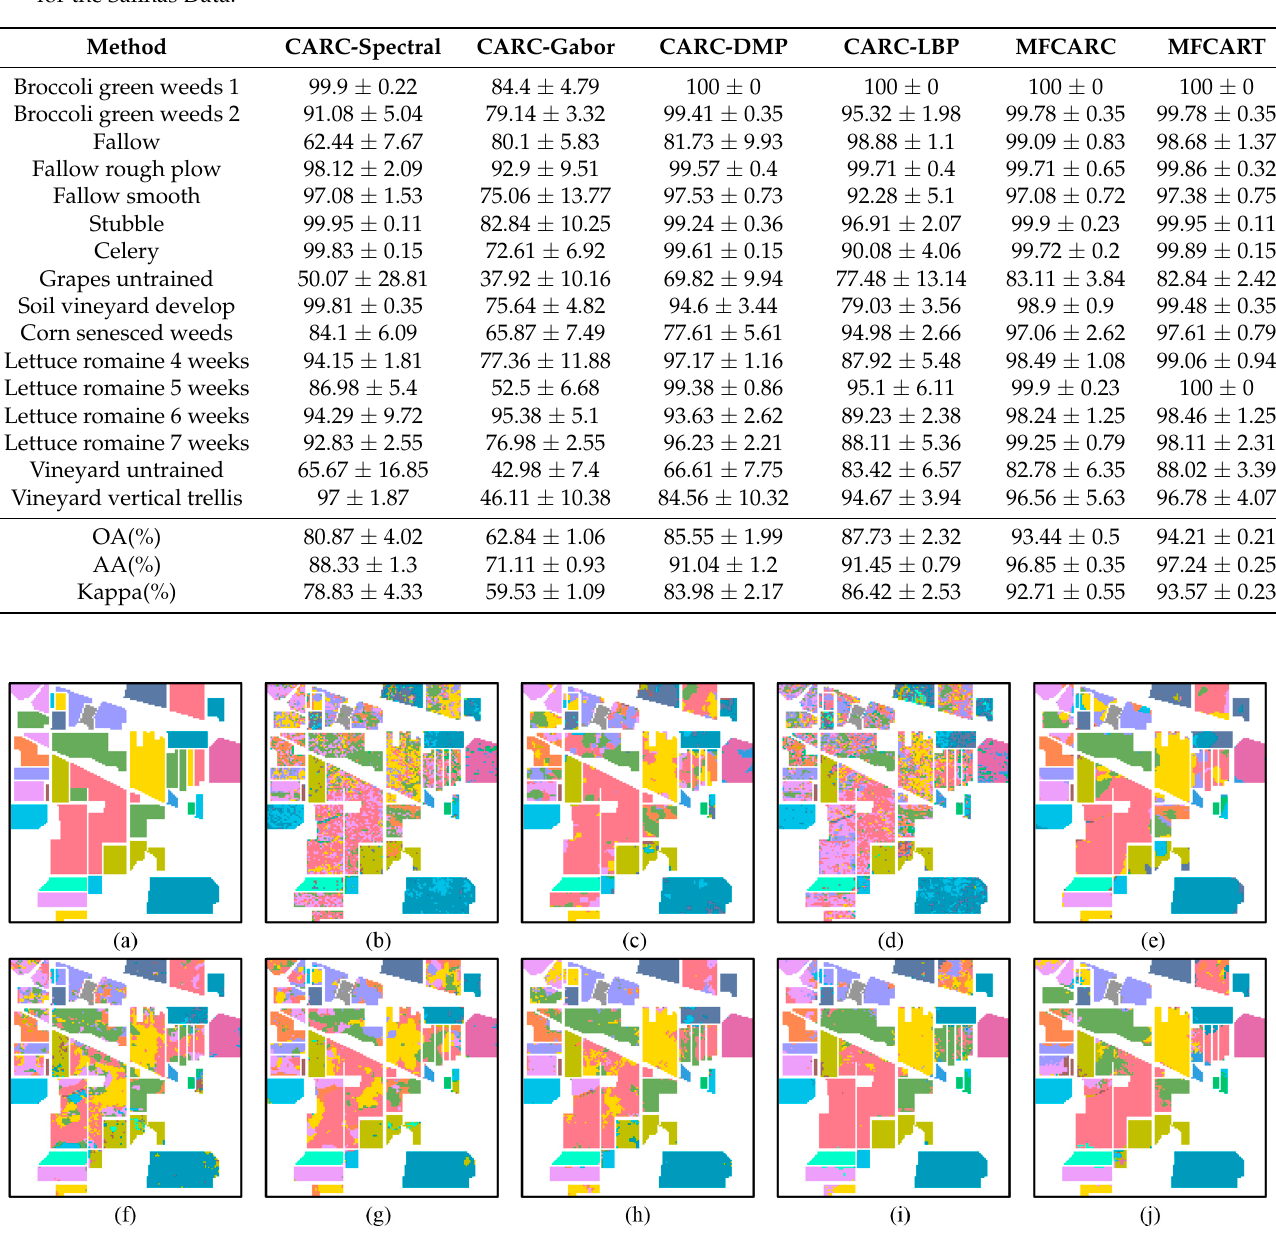
Figure 7. Ground truth and classification maps for the Indian Pines data set. ( a ) Ground truth. ( b ) Kernel version of FRC (KFRC). ( c ) Multiscale adaptive sparse rep-resentation classification (MASR). ( d ) Collaborative representation classification with Tikhonov regularization (CRT). ( e ) kernel fused representation classification via the composite kernel with ideal regularization (KFRC-CKIR). ( f ) multiple feature sparse representation classification (MF-SRC). ( g ) multiple feature joint sparse representation classification (MF-JSRC). ( h ) Multi-feature based adaptive sparse representation (MFASR). ( i ) Multi-feature correlation adaptive representation-based classifier (MFCARC). ( j ) MFCARC with Tikhonov regularization (MFCART).